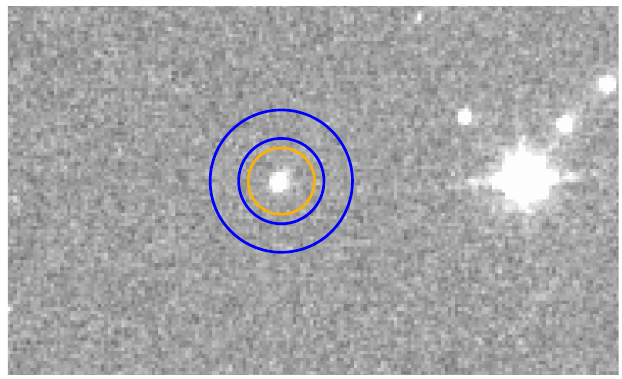
Fig. 14.— Aperture photometry in a part of the Hubble Space Telescope image of Westerlund 2. Image credit: NASA, ESA, the Hubble Heritage Team (STScI/AURA), A. Nota (ESA/STScI), and the Westerlund 2 Science Team